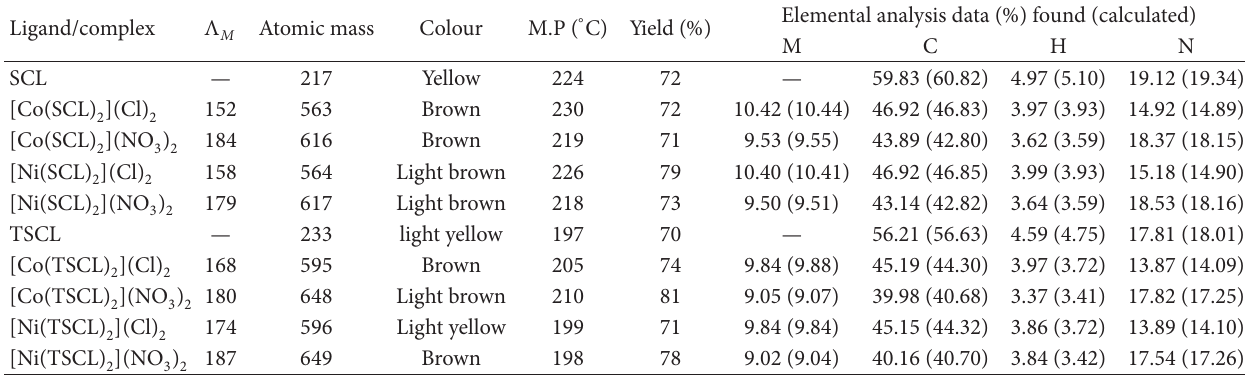
T 1: Molar conductance and elemental analysis